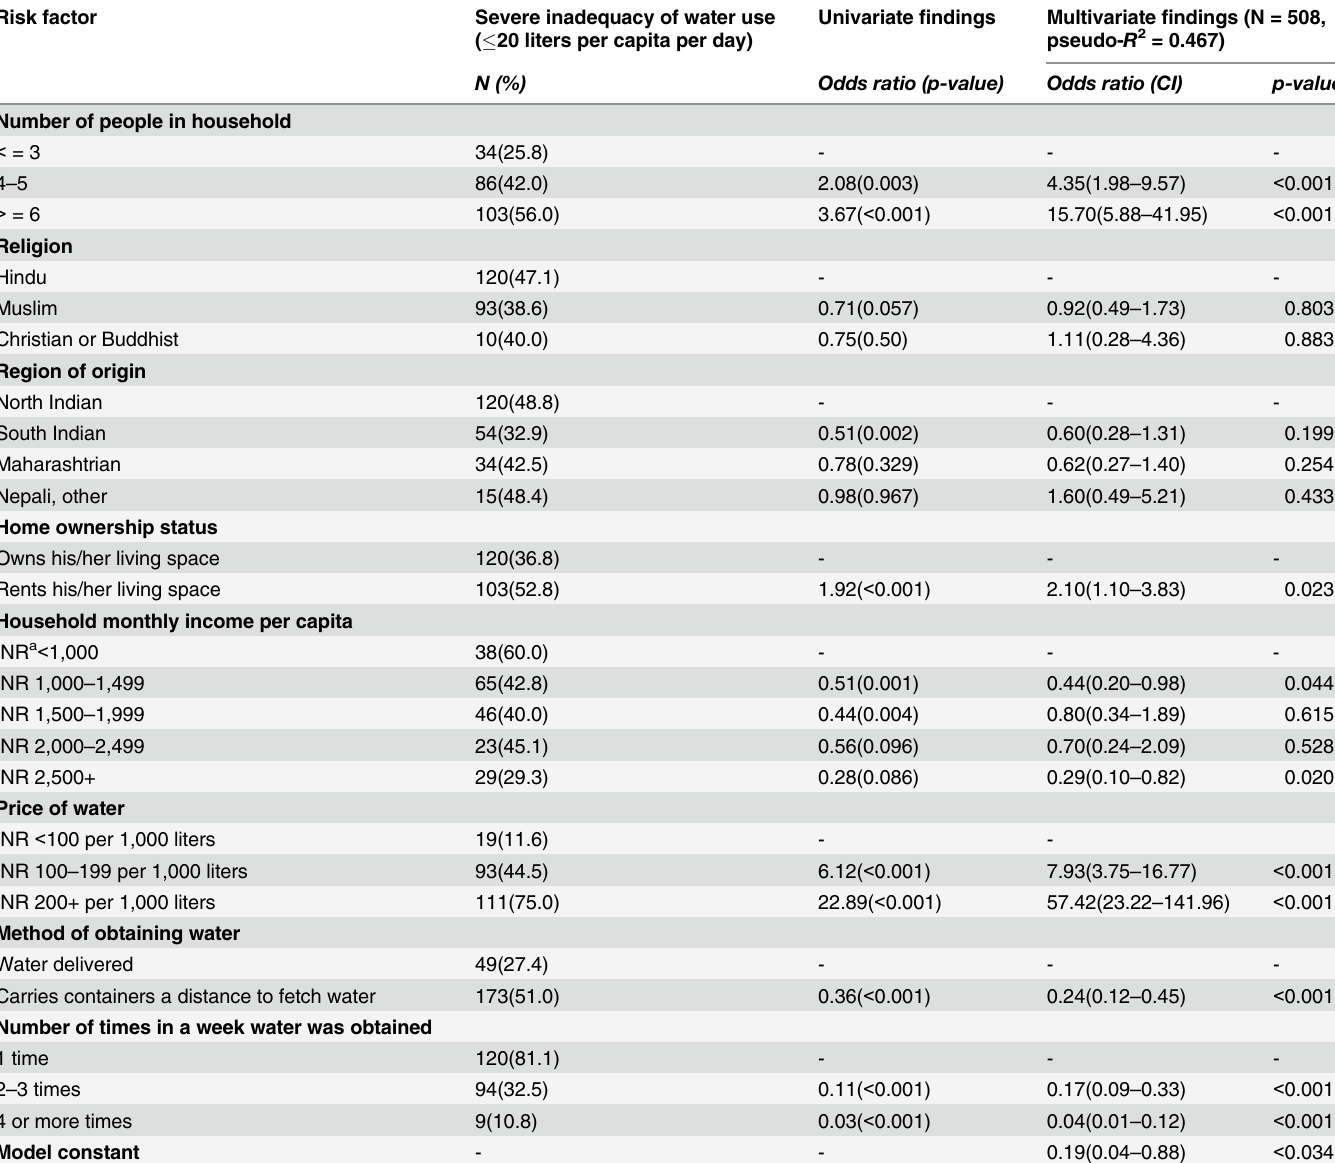
Table 2. Predictors of inadequate water quantity in a multivariate logistic regression